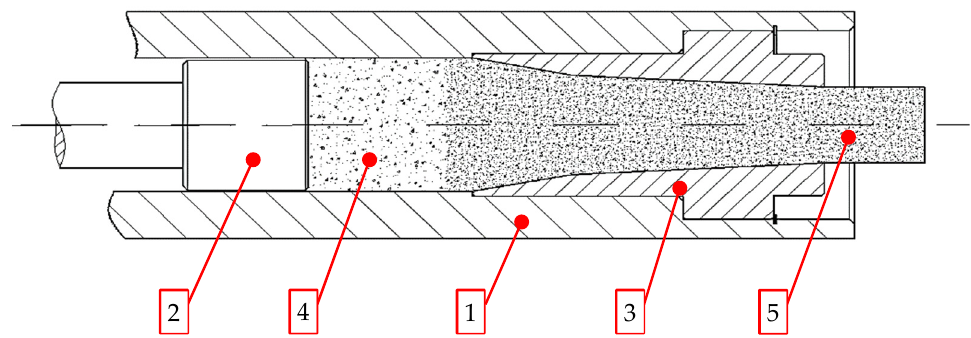
Figure 1. Main parts of the ram-type extruder: 1—compression cavity, 2—ram, 3—die, 4—loose dry ice, 5—compressed dry ice [17].